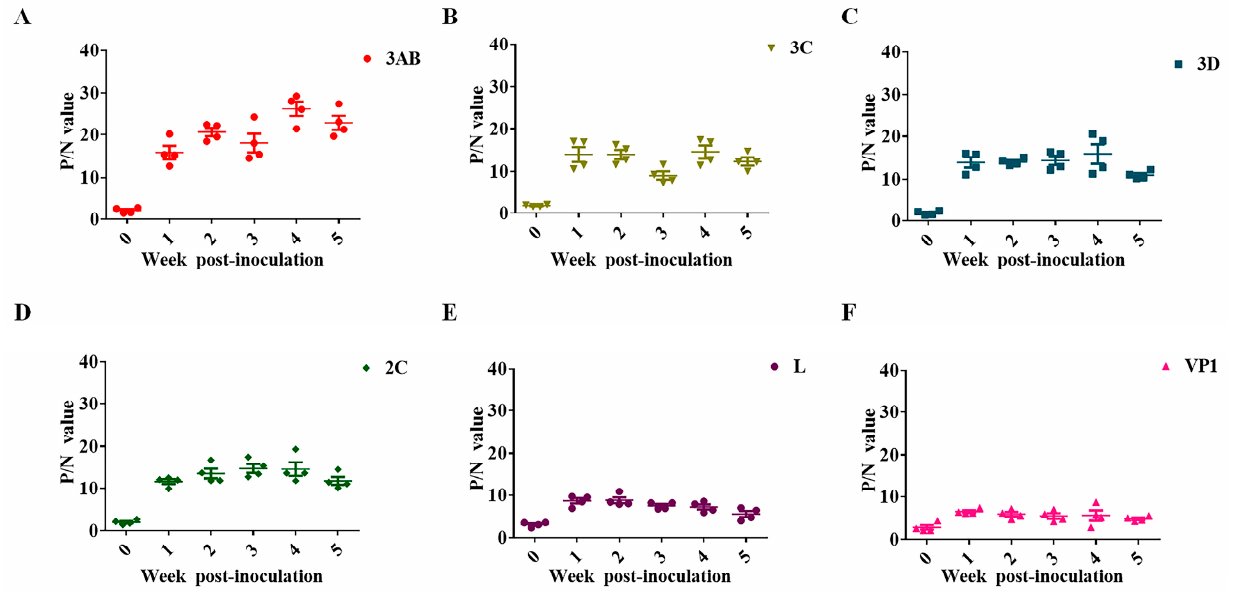
Figure 2. Dynamic analysis of antibodies encoding different viral proteins in SVA-infected swine. ( A ) Antibody kinetics against the SVA 3AB protein. ( B ) Antibody kinetics against the SVA 3C protein. ( C ) Antibody kinetics against the SVA 3D protein. ( D ) Antibody kinetics against the SVA 2C protein. ( E ) Antibody kinetics against the SVA L protein. ( F ) Antibody kinetics against the SVA VP1 protein. P/N value, the ratio of positive control to a negative control.